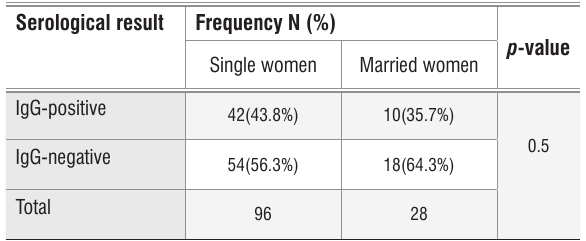
Comparison of the seroprevalence of anti- Toxoplasma IgG anti-